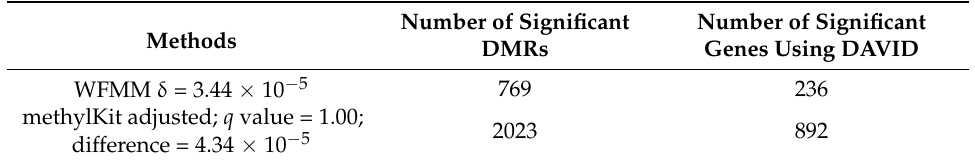
Figure 6. Gene ontology of molecular function for significant differentially methylated TAIR genes detected by WFMM with δ = 0.01 ( a ) and methylKit with default settings (difference = 25; q value = 0.01) ( b ). Table 2. Number of intersecting genes between 484 genes identified by Malay Das et al. [20] that are related to herbicide glyphosate stress and significant genes identified by WFMM and